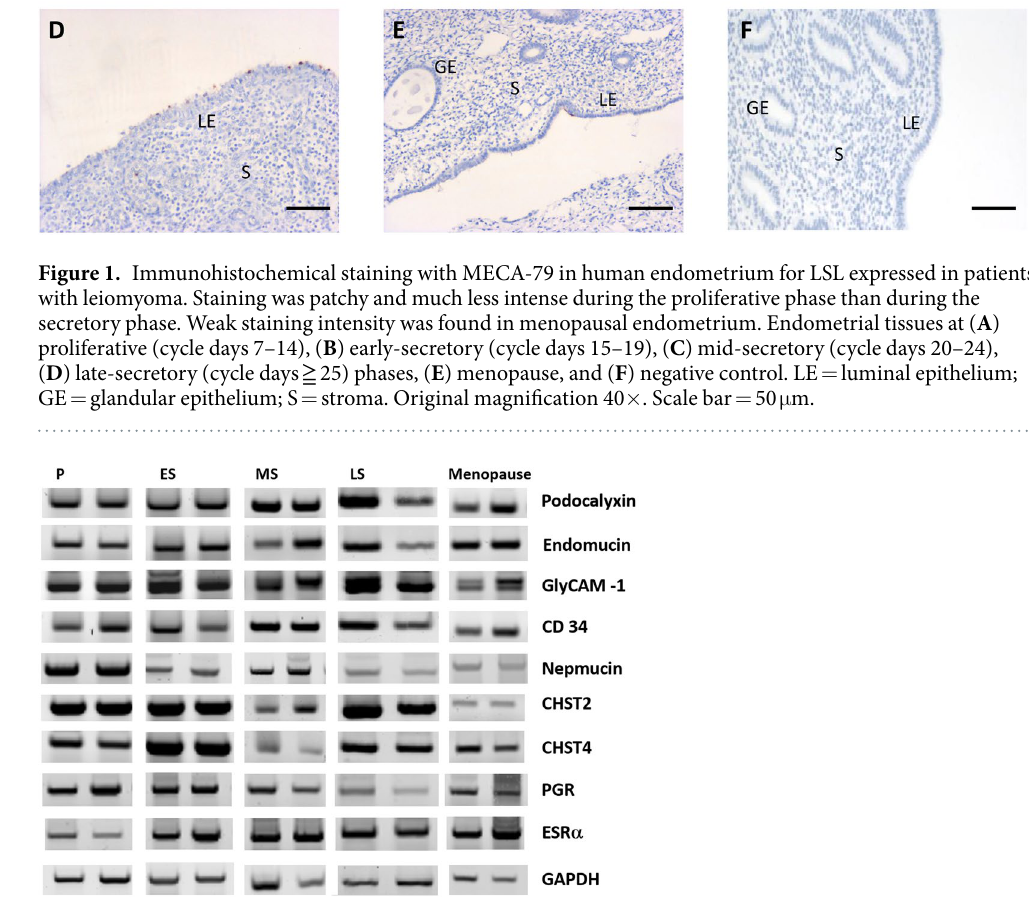
(P < 0.05) (Fig. 3). However, in our previous study, the expression of MECA-79 epitope on LSLs was upregulated during the luteal phase and downregulated during the proliferative phase. LSL reached the highest expression at the early to mid-secretory phases, which coincides with the window of implantation 7 . This suggests that the assembly of LSLs involves in the production of LSL peptide components beginning in the proliferative phase and then post-translational modification with oligosaccharides mainly in the early and mid-secretory phases. We found that endomucin is the only LSL peptide component with significantly different relative fold changes between the proliferative and early-secretory phases (P < 0.05) (Fig. 3). The expression pattern throughout the cycle is almost consistent with the cyclic change of serum estrogen in the natural menstrual cycle. This raises a concern of whether cyclic-changed estrogen regulates the production of endomucin. Further studies are needed to elucidate this issue. Human endomucin is a 261-aa, 27.5-kDa protein with a transmembrane sequence and multiple glycosylation sites. Human endomucin is abundant in highly vascular tissues such as the heart, kidney, and lung 14 . Endomucin was specifically detected on endothelial cells of the blood and lymphatic vessels of most